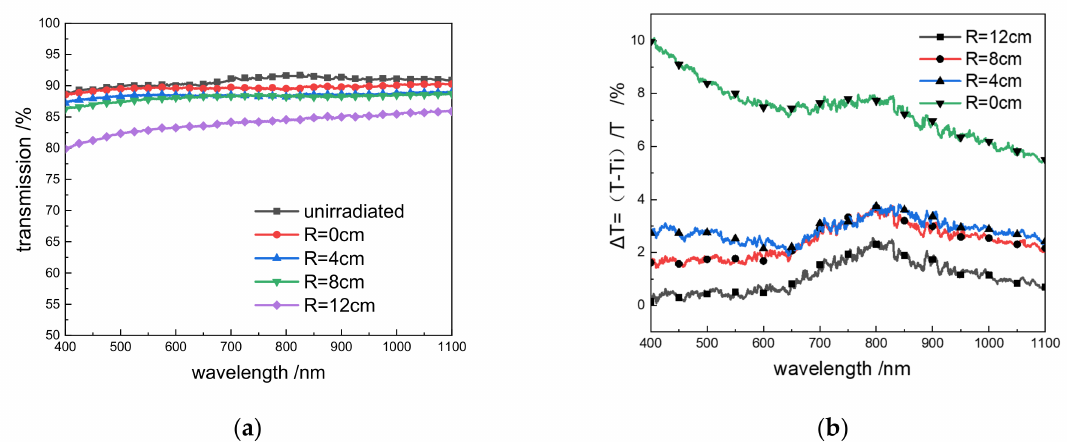
Figure 5. ( a ) After polishing, R = 0 cm, R = 4 cm, R = 8 cm, R = 12 cm and the transmittance of unirradiated glass after polishing; ( b ) The ratio of the transmittance between different positions of the glass and the unirradiated glass ∆ T = (T − Ti)/T, T is the transmittance of unirradiated